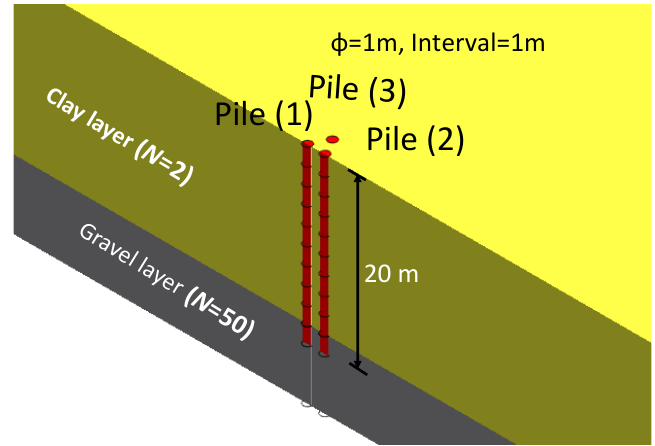
Figure 2. Process of pulling out existing piles.